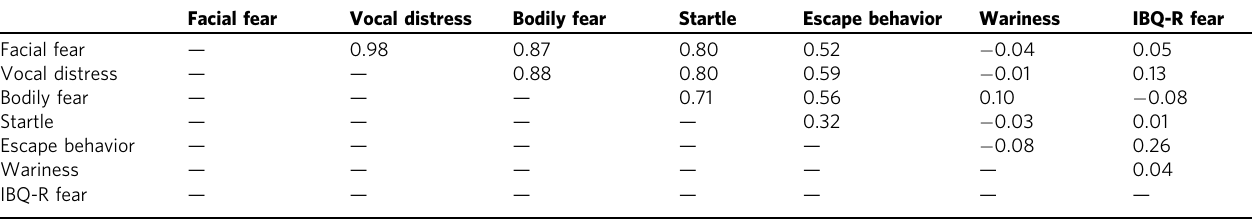
Table 1 Spearman correlations between fear behavior outcomes at 1 year of